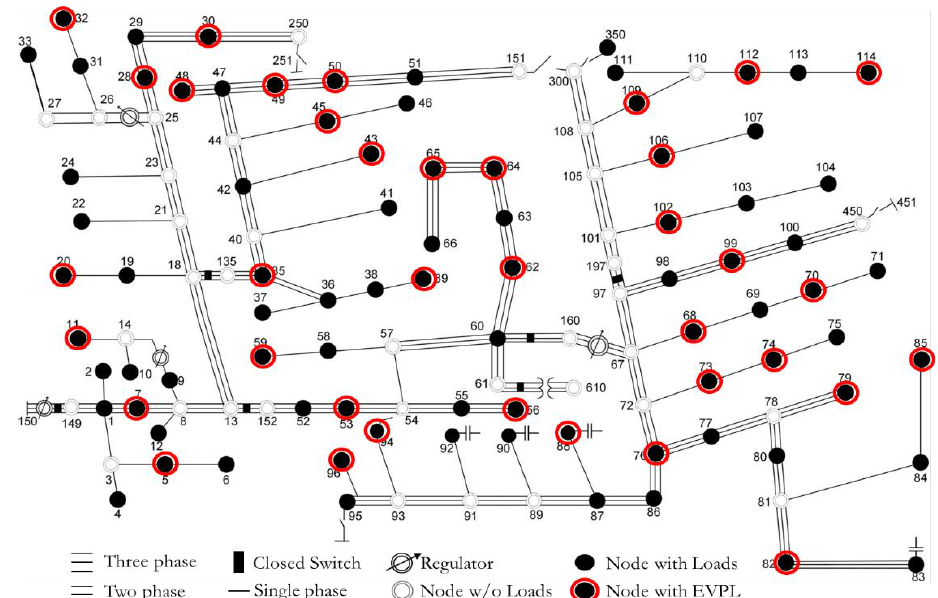
Energies 2021 , 14 , x FOR PEER REVIEW 17 of 28